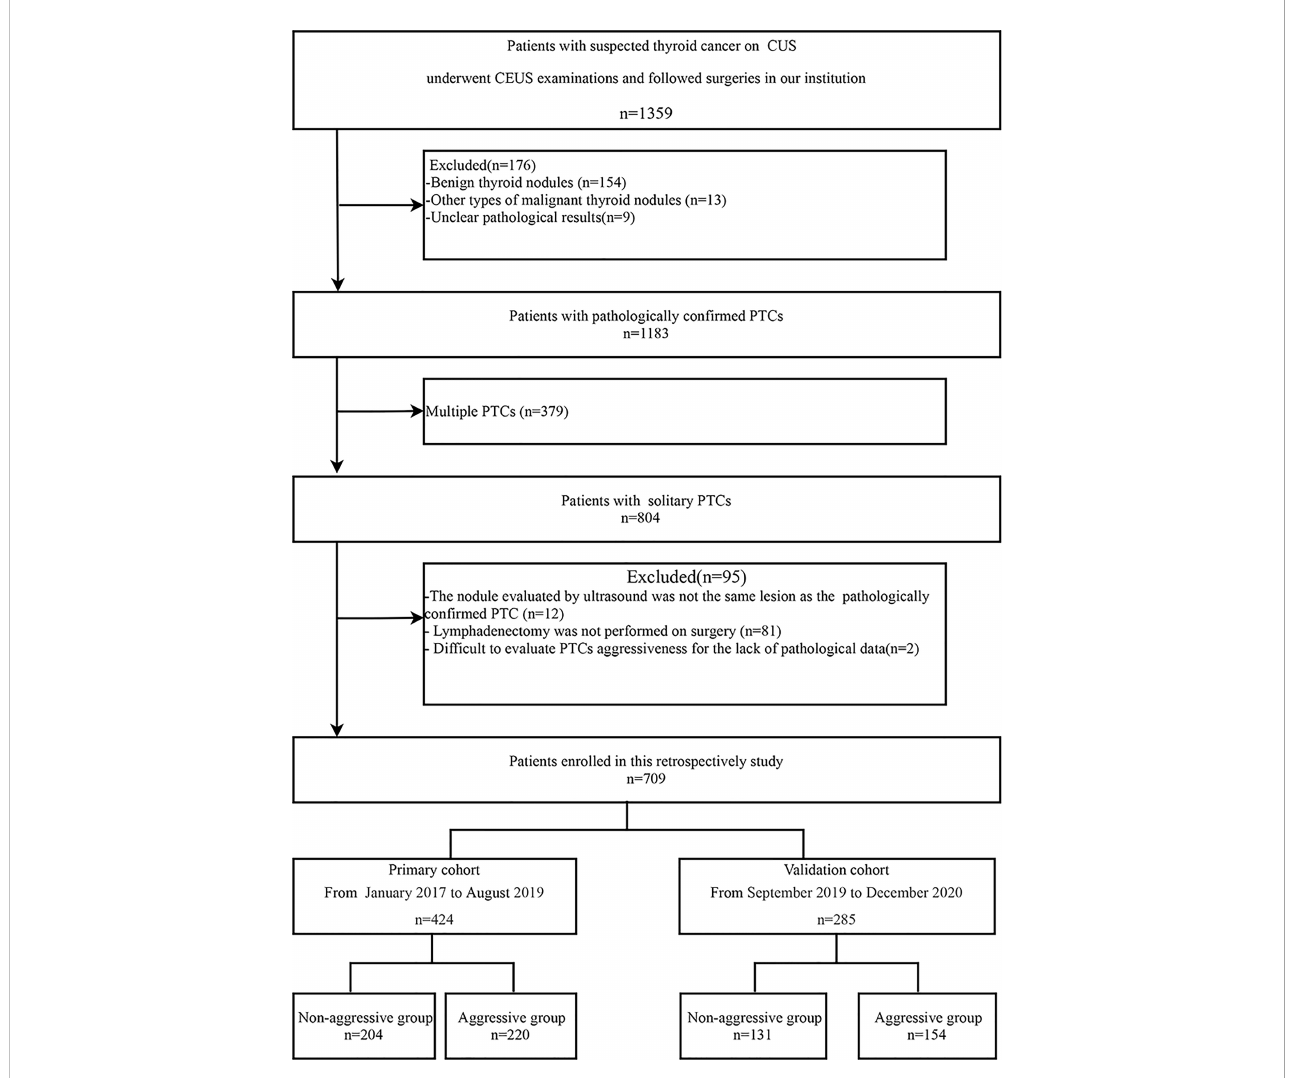
FIGURE 1 Flow chart showing patient selection process. PTC, papillary thyroid carcinoma; CUS, conventional ultrasound; CEUS, contrast enhanced